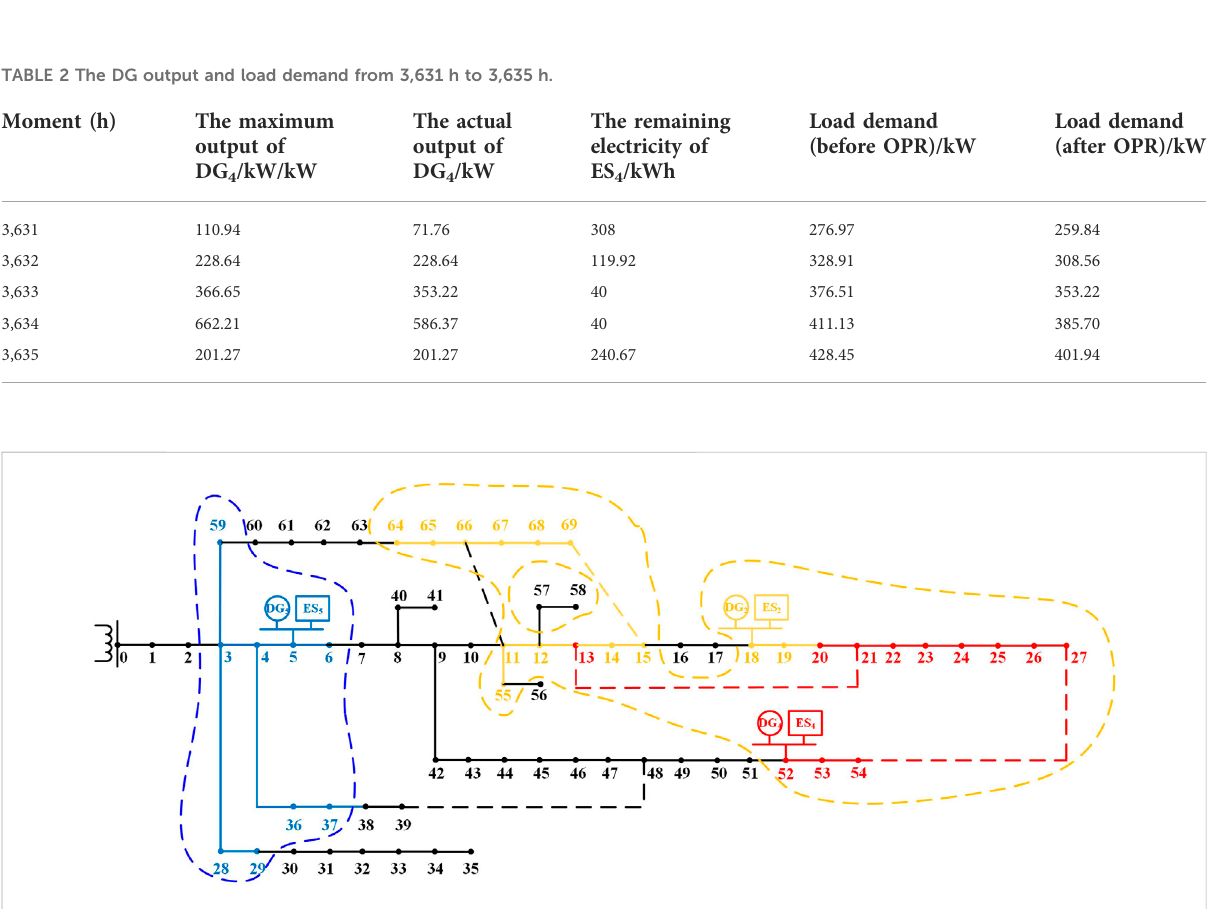
FIGURE 5 Final island partition